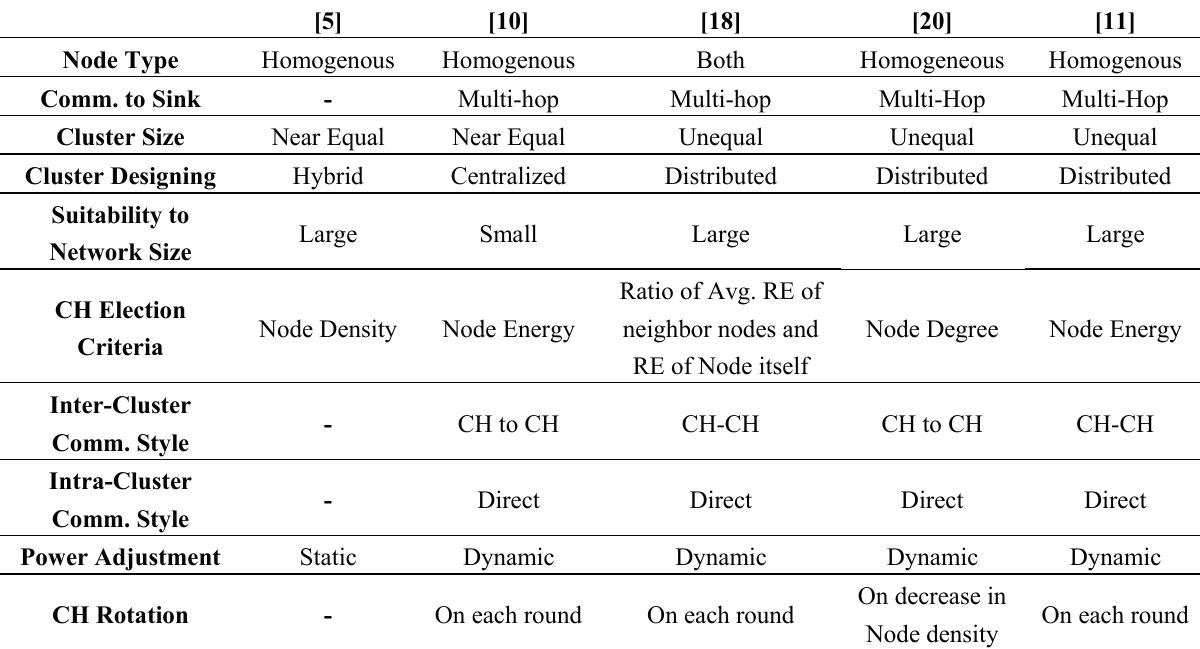
Table 1. Comparative analysis of clustering algorithm on various network design and operational